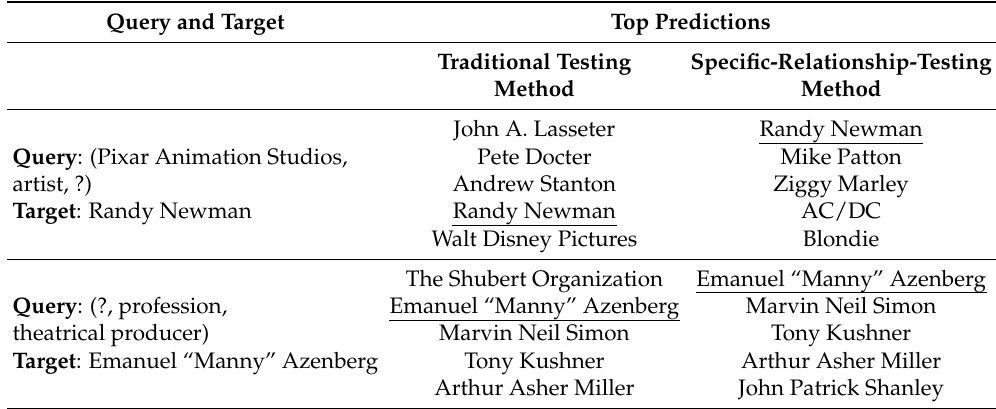
Table 8. Two examples of top five predictions for the given queries. Two test triples were selected from the FB15k-237 test data set. The target in top predictions is underlined. Query and